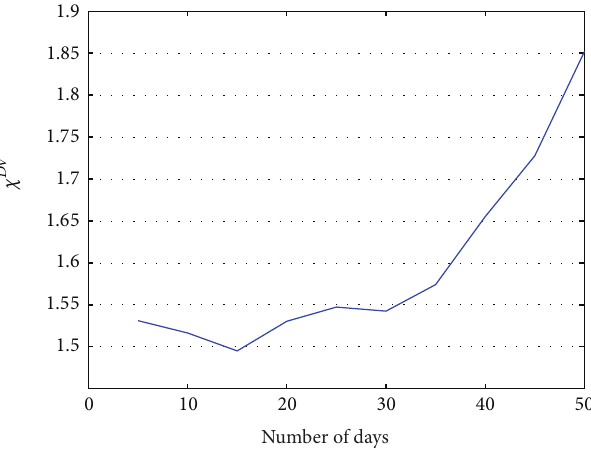
Figure 3: 𝜒 2 deviation values under different time interval